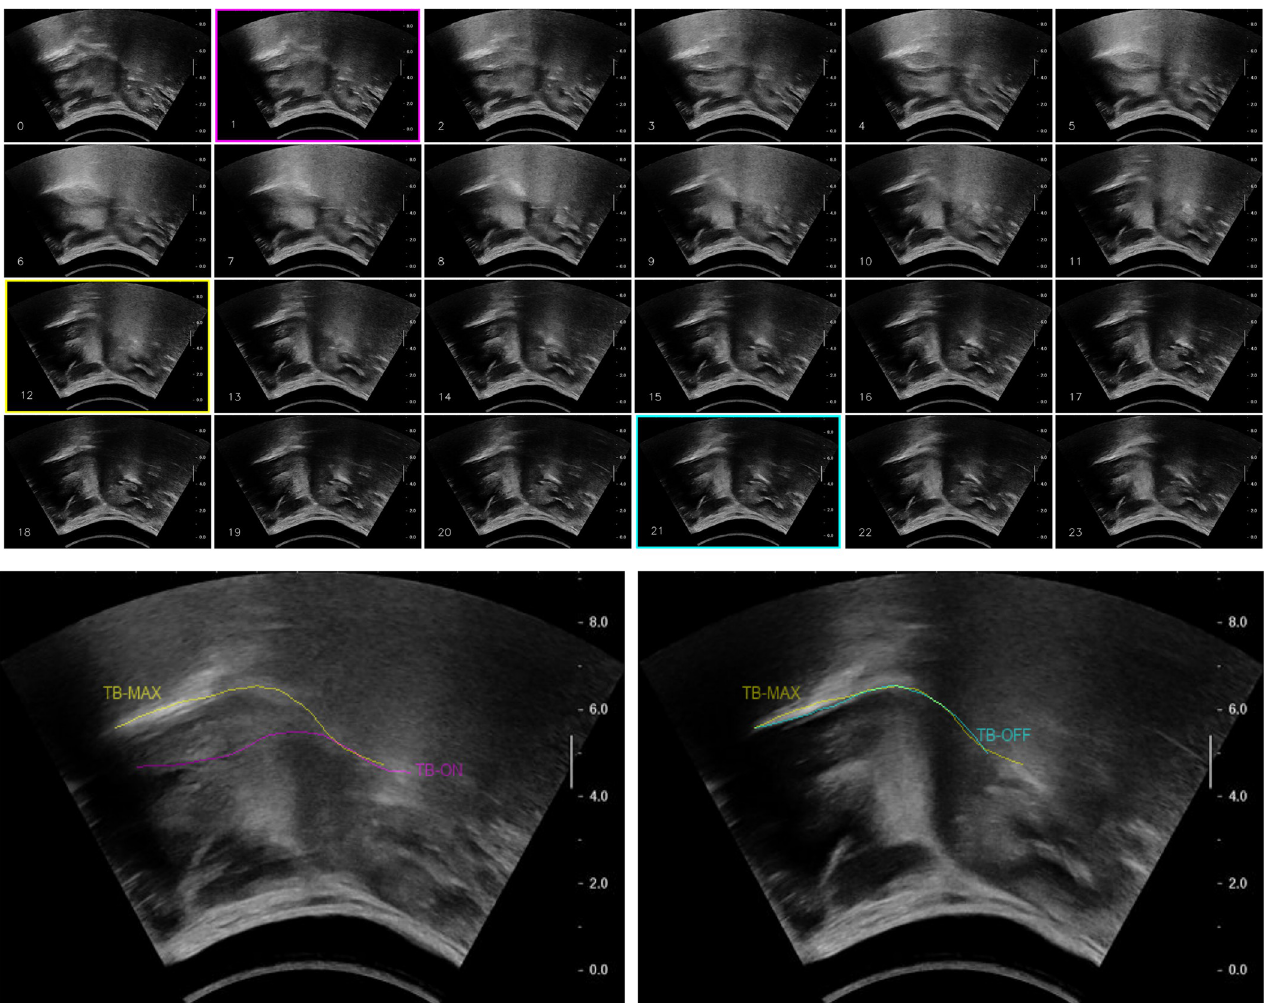
Fig 2. (a) Numbered sequential juxtaposition of sample tongue base retraction frames (from left to right, top to bottom); (b) corresponding superimpositions of TBOn/TBMax (left) and TBMax / TBOff (right). Note : Magenta frame = TBOn , Yellow frame = TBMax , Cyan frame = TBOff